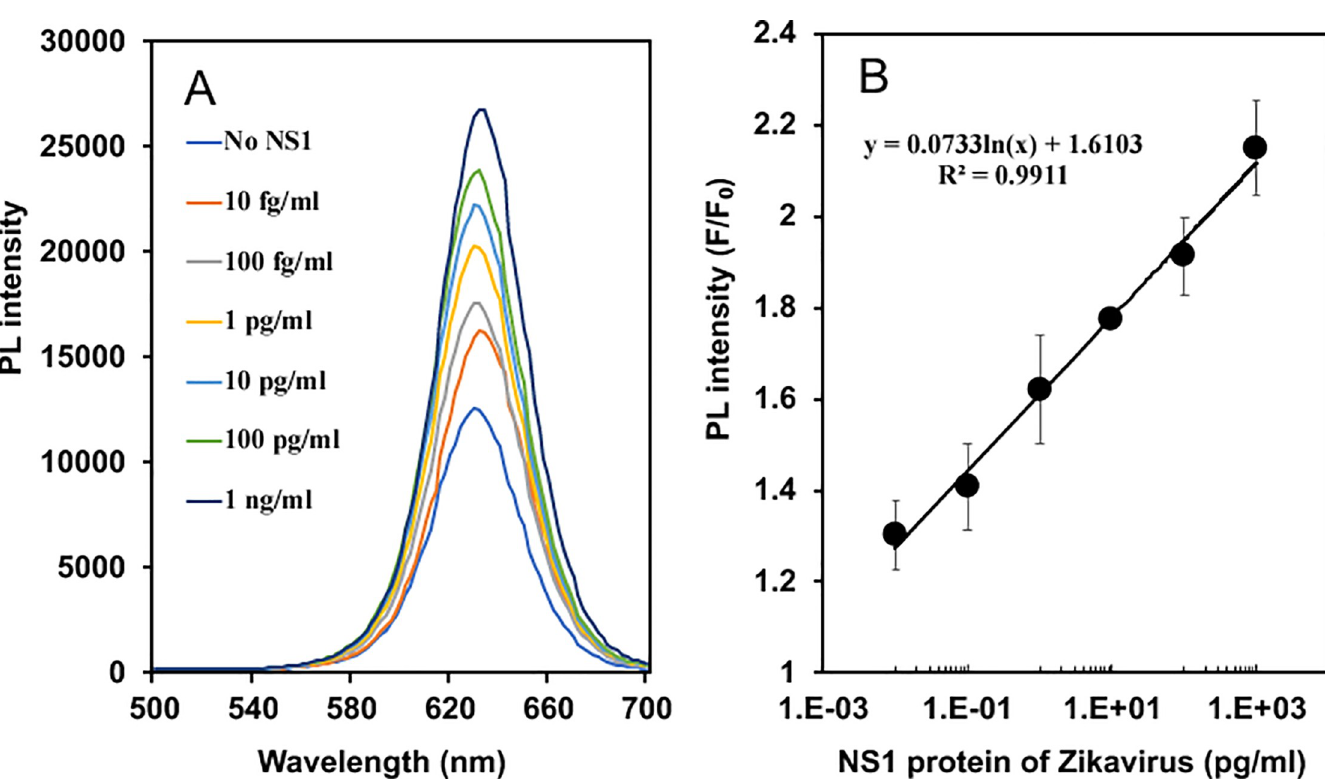
Fig 4. Fluorescence intensity in ZIKV detection using Ab-MPA-AuNPs and Ab-QDs and calibration curve. Fluorescence enhancement spectra (A) of the Ab-QDs and calibration curve (B) of the recombinant NS1 antigen using the LSPR signal amplifier of Ab-MPA-AuNPs.